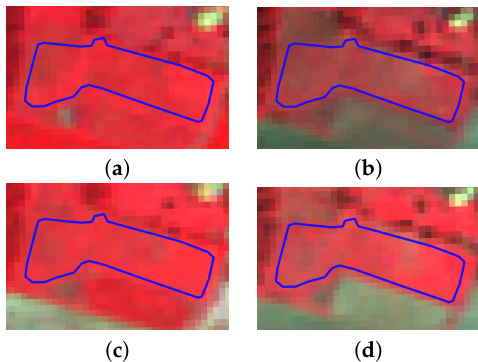
Figure 5. False color Formosat-2 images of the same grassland on two close dates (June and October) in 2013 and 2014 with the same color scale. ( a ) 6 June 2013, ( b ) 27 October 2013, ( c ) 5 June 2014, ( d ) 23 October 2014. The blue line represents the polygon limits of the grassland. Table 1. Composition of the old and young grasslands’